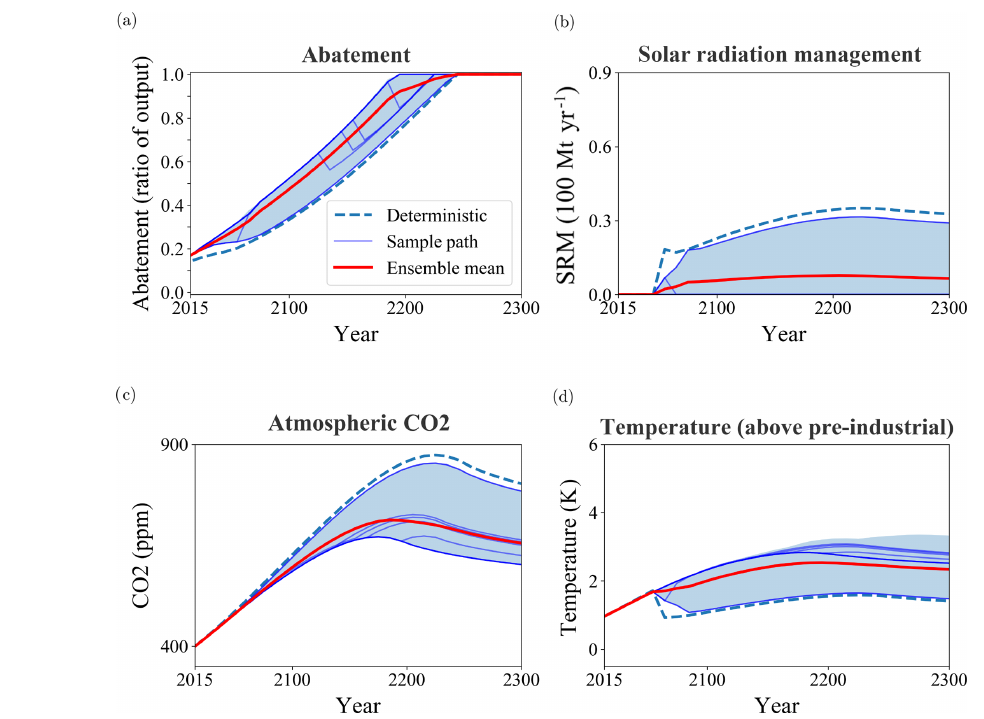
Figure 4. Optimal policy and climate development for the realistic storyline scenario. (a) Abatement fraction, (b) SRM in 100Mt(S)yr − 1 , (c) atmospheric carbon concentration in ppmv, (d) global mean temperature change w.r.t. pre-industrial temperature. The thin blue lines represent a sample of individual ensemble members, the thick red line the ensemble mean, and the blue shaded area indicates the range of possible values in the whole ensemble. The dashed blue line depicts the results from a deterministic reference case in which SRM becomes available in 2055 certainly and neither SRM failure nor climate tipping